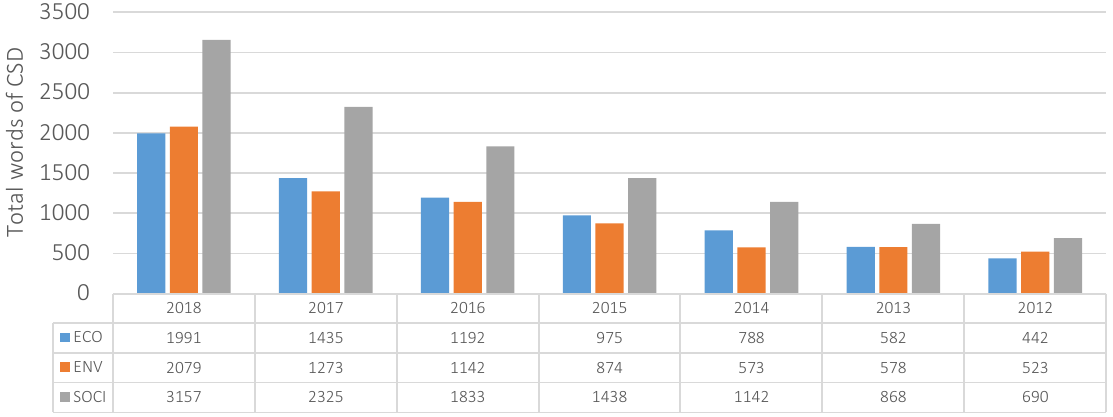
Figure 1. Total words of CSD from 2012 to